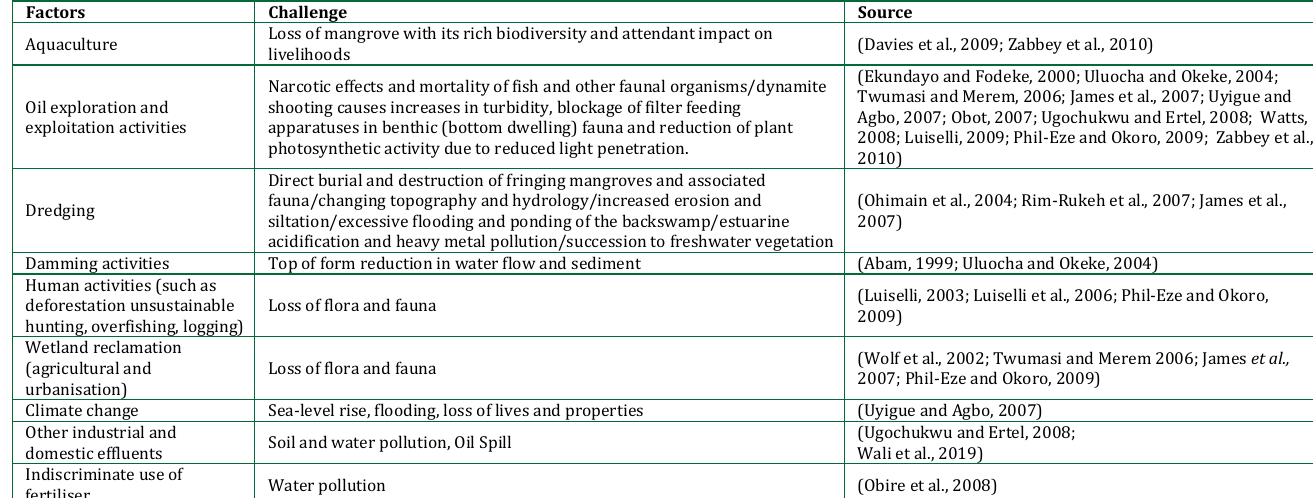
Table 1 : Challenges of the Niger Delta wetlands